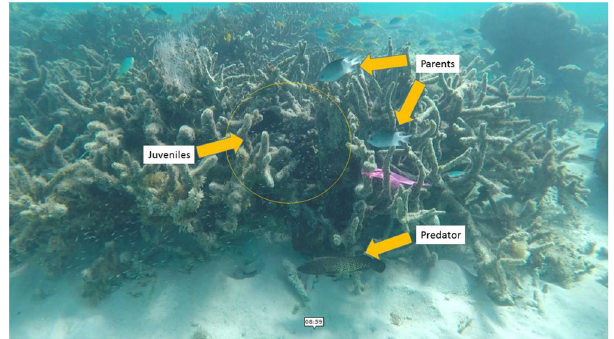
Fig. 4 Spiny chromis ( Acanthochromis polyacanthus ) nest at the edge of coral reef habitat. Parents, juveniles and a predator (peacock grouper, Cephalopholis argus ) can be seen in this photo. Photo credit: S Nedelec.